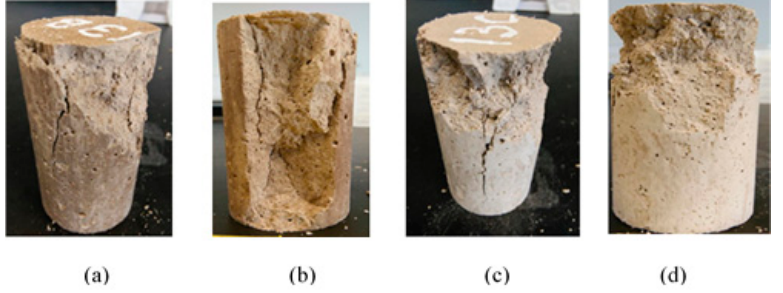
Figure 5. The failure mode of the samples subjected to a compressive strength test ( a ) Design 1, ( b ) Design 2, ( c ) Design 3, and ( d ) Design 4.